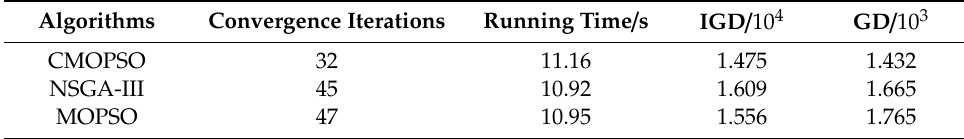
Table 6. Algorithm performance comparison (CMOPSO, NSGA-III,